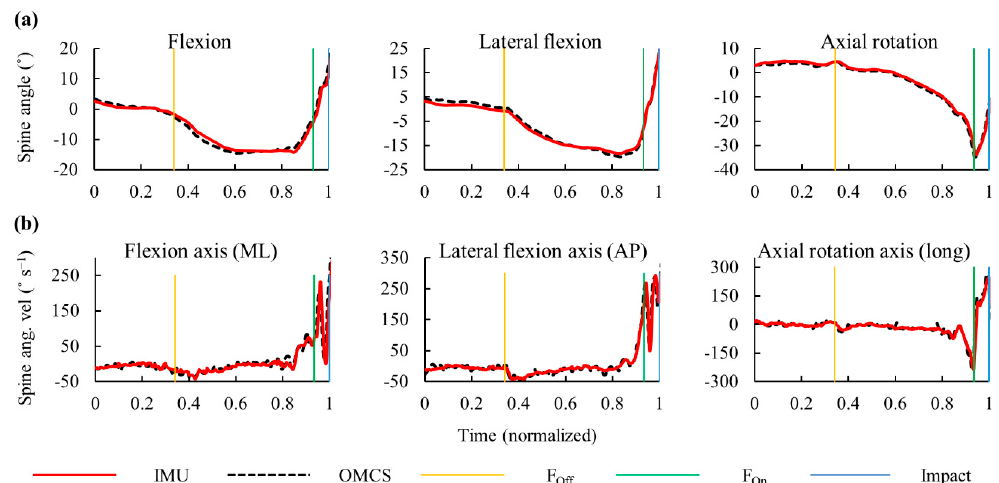
Figure 5. Typical graph of time-dependent change in ( a ) angular displacement and ( b ) angular velocity (ang. vel.) of the spine joint measured using the inertial measurement units (IMUs) and the optical motion capture system (OMCS). The vertical lines represent foot-off (F off ), foot-on (F on ), and impact events. ML: Medio-lateral axis, AP: Antero-posterior axis, Long: Longitudinal axis.